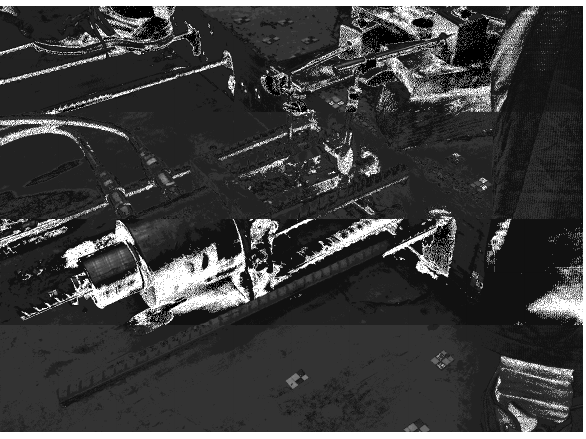
Figure 2. Test Field